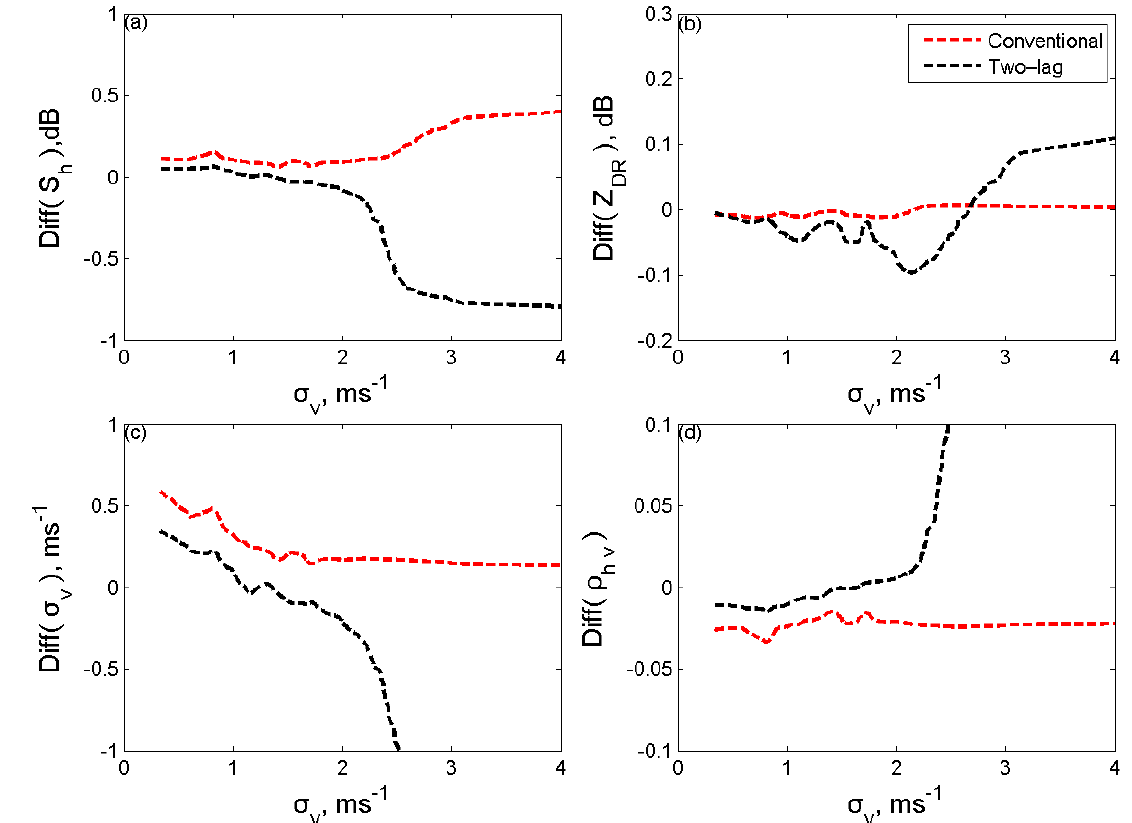
Figure 10. The difference of conventional estimators and two-lag estimators from radial A, B and C. ( a ) S h ; ( b ) Z DR ; ( c ) σ v ; and ( d ) ρ hv . These values are calculated gate by gate through subtracting the reference value and only the data with the SNR less than 20 dB are taken into account.